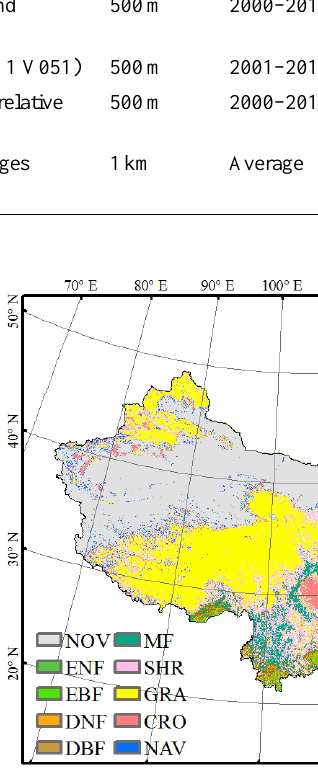
Fig. 1. Land cover map of China in 2010 derived from the MODIS land cover data set: ENF – evergreen needleleaf forest; EBF – ever- green broadleaf forest; DNF – deciduous needleleaf forest; DBF – deciduous broadleaf forest; MF – mixed forest; SHR – shrubland; GRA – grassland; CRO – cropland; NAV – cropland/natural vege- tation mosaic; NOV –